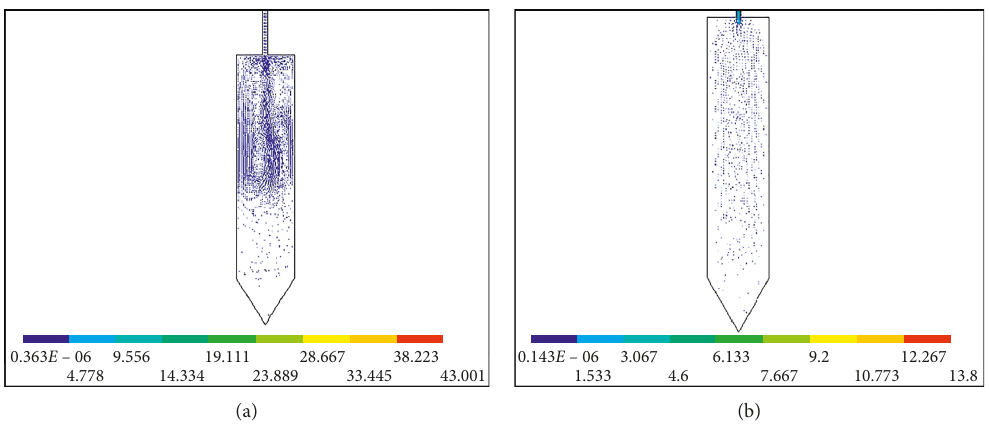
Figure 9: Speed vectors in the stock bin at different time periods. (a) Speed vector in the stock bin at the maximum speed. (b) Speed vector in the stock bin when sacked gangue is